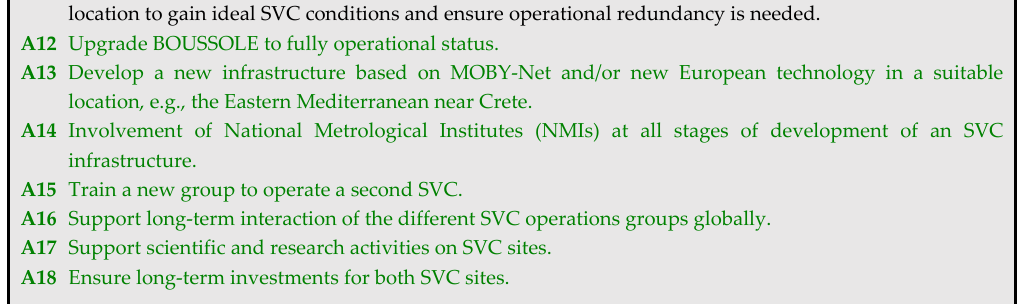
Figure 26. Conclusions ( C ) from the FRM4SOC project and their recommended actions ( A ).